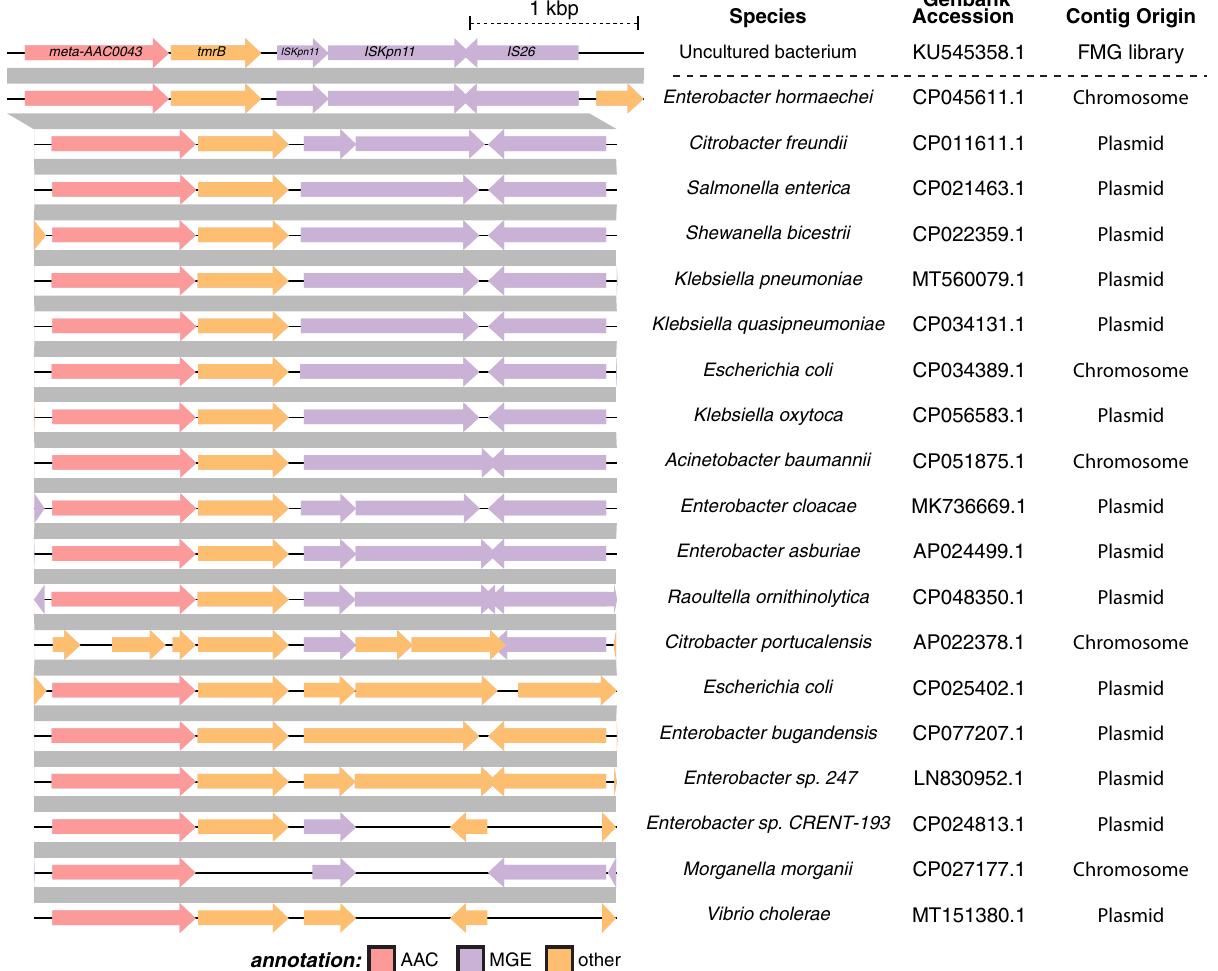
Fig. 5 Synteny of meta-AAC0043 with mobile genetic elements. The contig containing meta-AAC0043 was queried against the NCBI nucleotide database and fi ltered for highly similar sequences, revealing the presence of similar sequences in a hugely diverse set of taxa. A representative set of similar genomic segments are shown, with gray bars indicating blastn percent identity ≥ 99.5%. Many of these matches are from plasmid sequences, and almost all of them contain ORFs annotated as MGEs (e.g., transposons, insertion sequences,